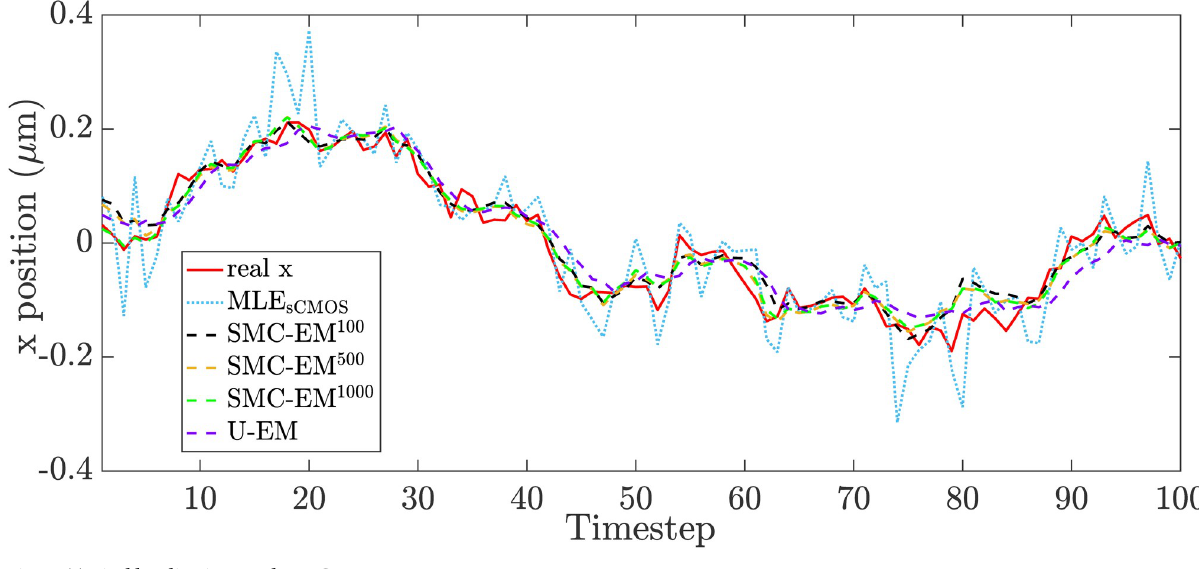
Fig 16. Typical localization results at G = N bgd =